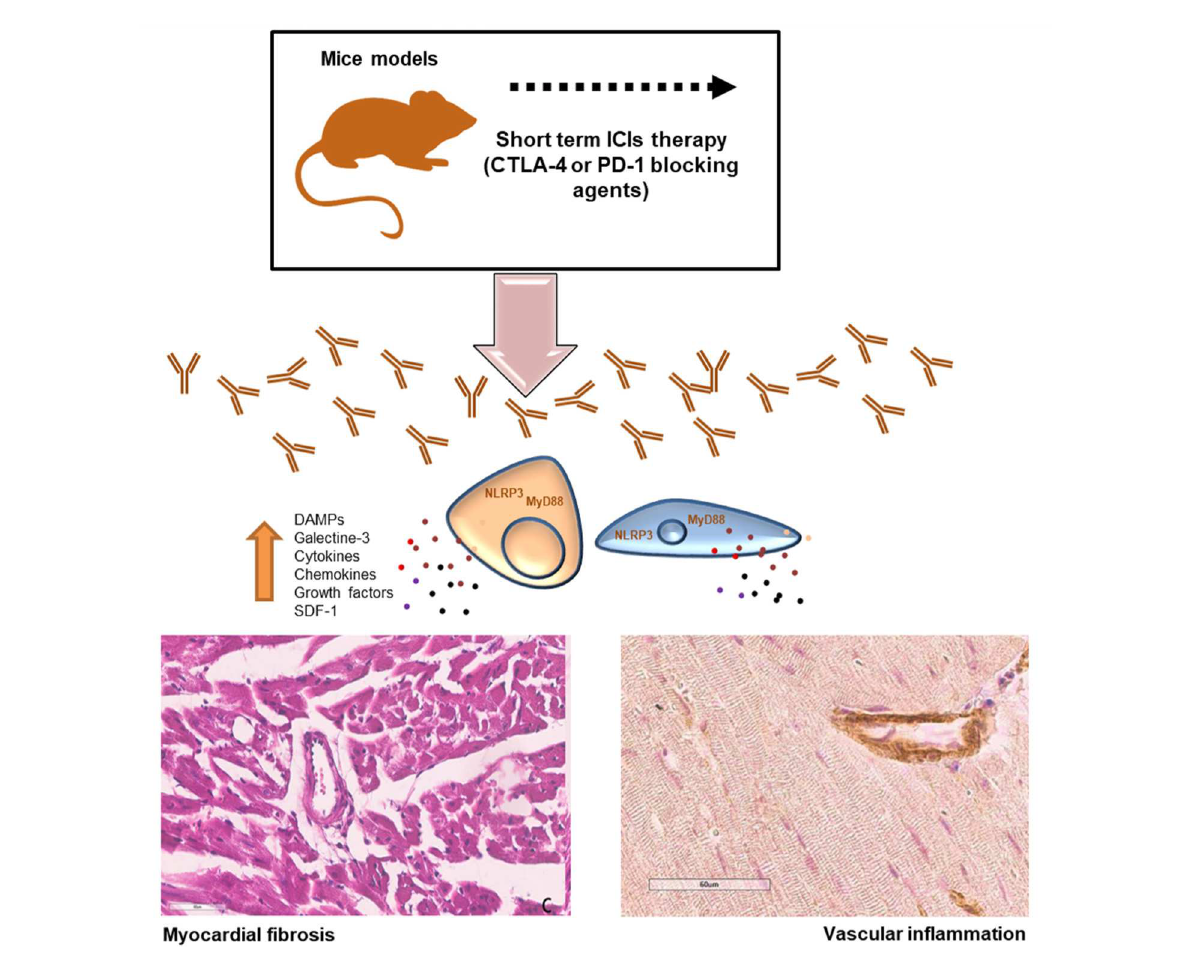
FIGURE8 Short-term ICI Therapy increases DAMPs, NLRP3 and MyD-88 mediated fibrosis and vascular inflammation. Short-term treatment with immune checkpoint inhibitors (ICIs) induced significant increases in DAMPs, galectine-3, cytokines and chemokines through NLRP3 and MyD88 pathways inducing myocardial hypertrophy, fibrosis and strong vascular